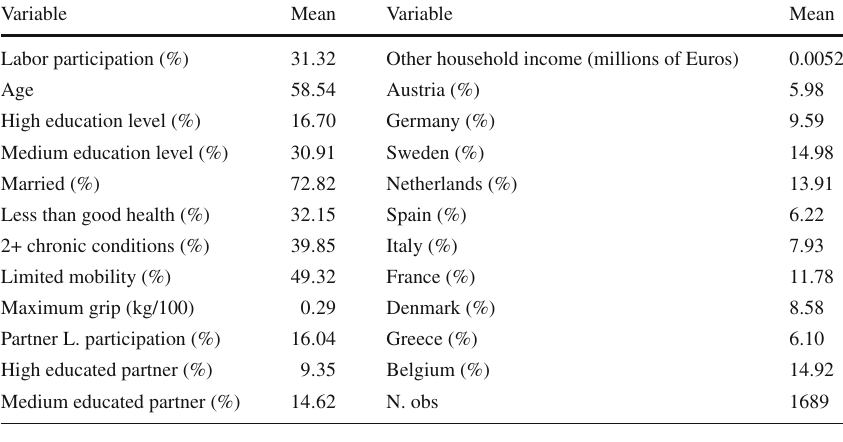
Table 5 Descriptive statistics grandmothers. Source : SHARE 2004 release2